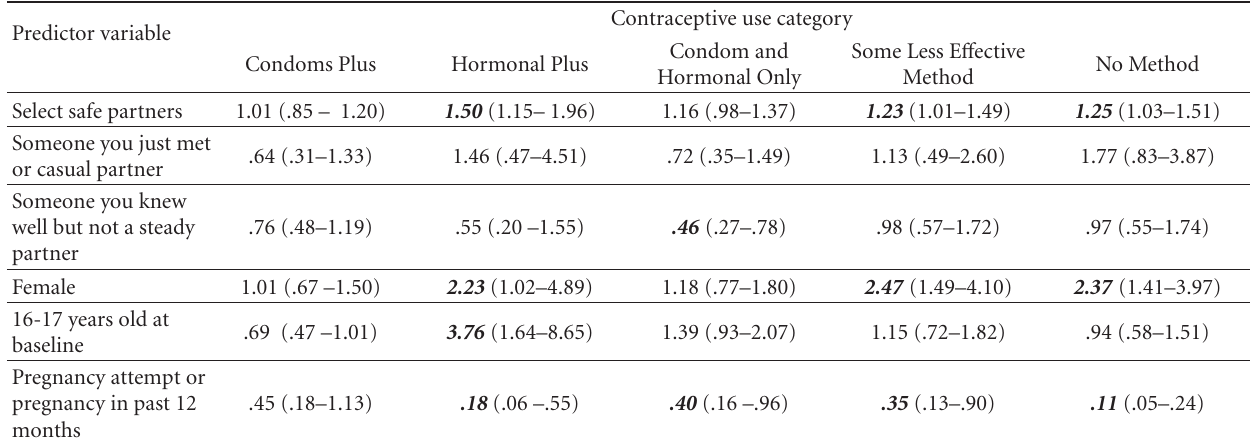
Figure 2: Tetrachoric correlations between contraceptive methods ( N = 850). Note: significance level of correlation below coe ffi cient. Table 1: Results of predicting dual/multiple contraceptive use typology ( N =